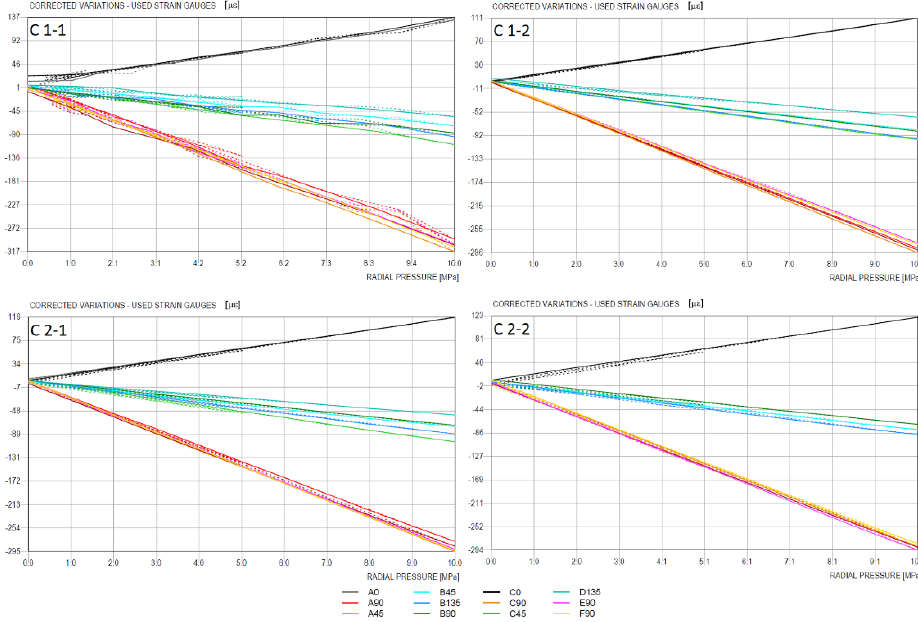
Figure 13. Stress–strain graphs of each specimen as obtained during the biaxial tests carried out through the Hoek–Franklin pressure cell. Deformation values ( µε ), registered by each oriented strain gauge, are reported in the y -axis versus the radial pressure (Mpa) in the x -axis.